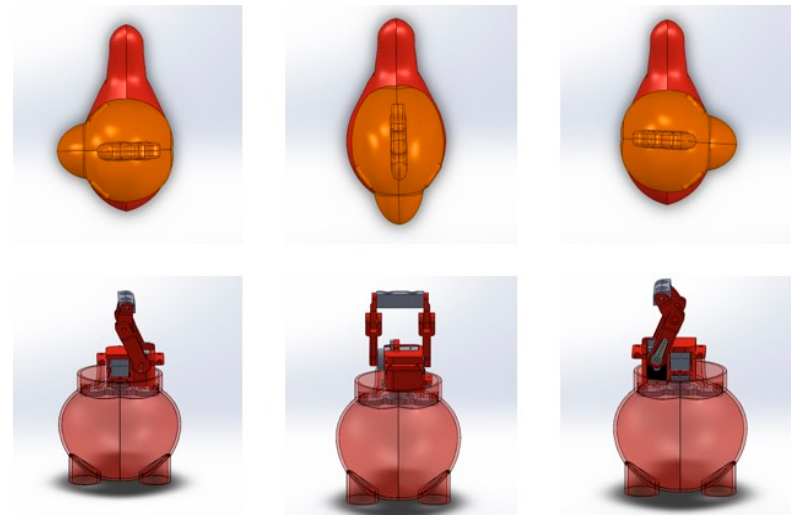
Figure 3. Wearable KiliRo robot’s head pose orientations. Figure 3 . Wearable KiliRo robot’s head pose orientations. Figure 3 . Wearable KiliRo robot’s head pose orientations.